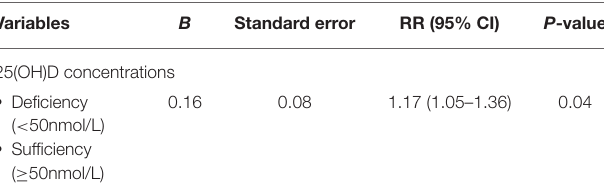
TABLE 4 | Longitudinal association between vitamin D concentrations of mothers throughout pregnancy and neonates at birth ( n = 179).